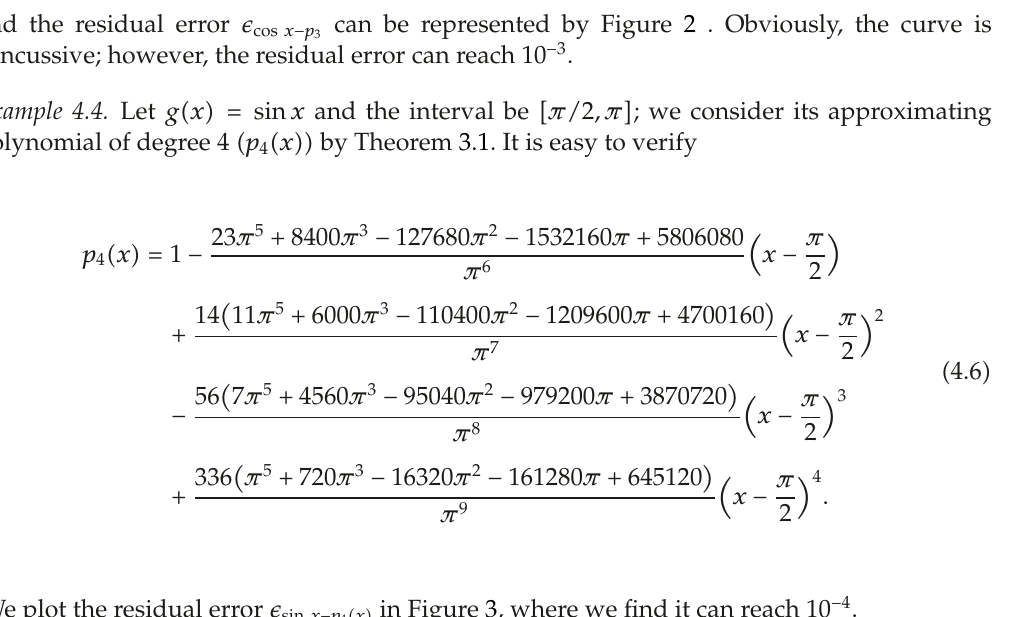
Figure 2: The residual error (cid:5) cos x − p